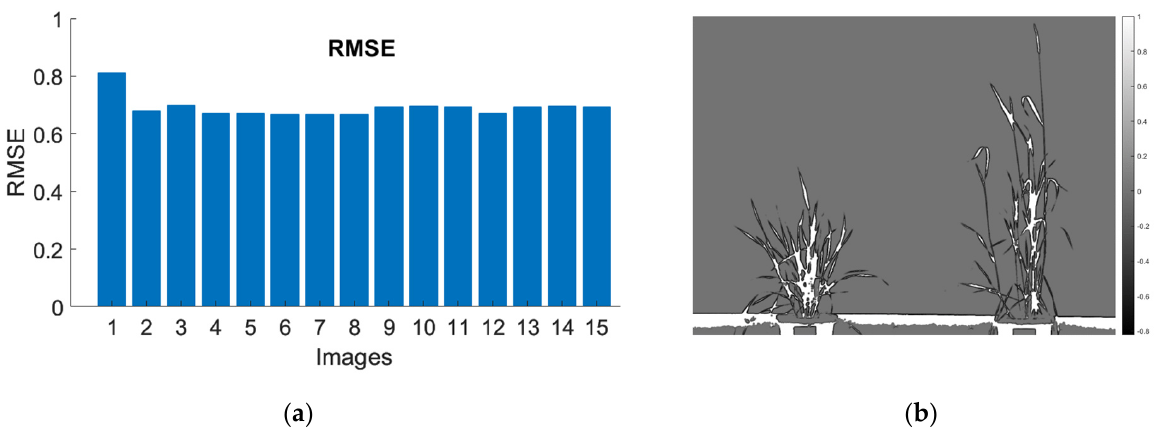
Figure 15. Error metric for segmentation: ( a ) Root Mean Square Error (RMSE) and ( b ) Structural Similarity Map (SSIM) between the original image and segmented images.